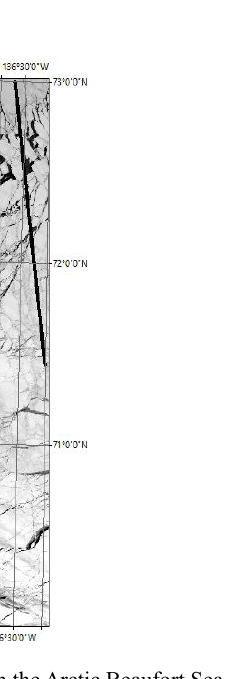
Figure1. experiments Area in the Arctic Beaufort Sea